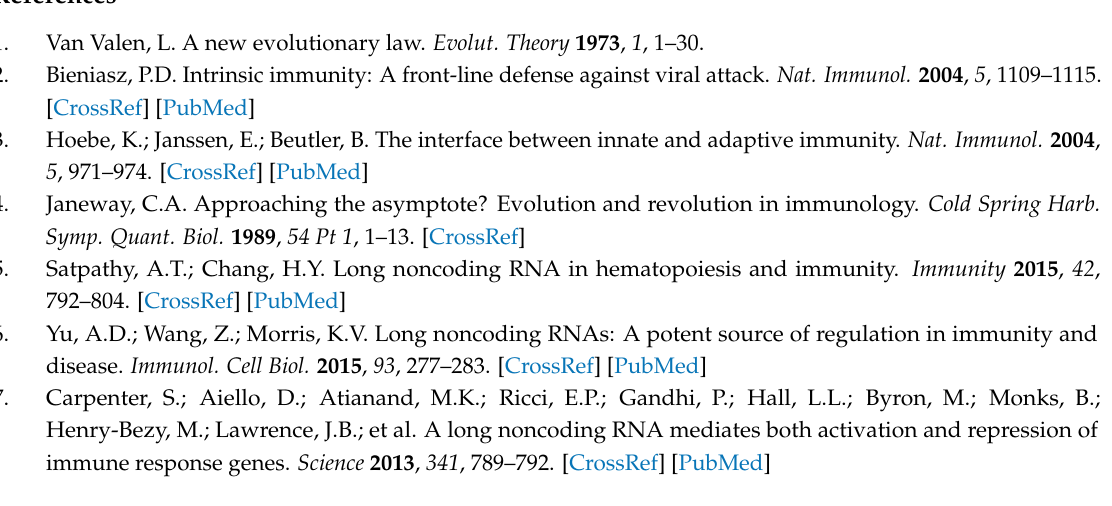
Figure S10: Raw image of western probing for MIR22HG; Table S1: List of smORFs encoded in lncRNAs identified upon viral infection, smORF sequences used in Figure 3 and the predicted sizes; Table S2: Comparison of RNAseq and qPCR